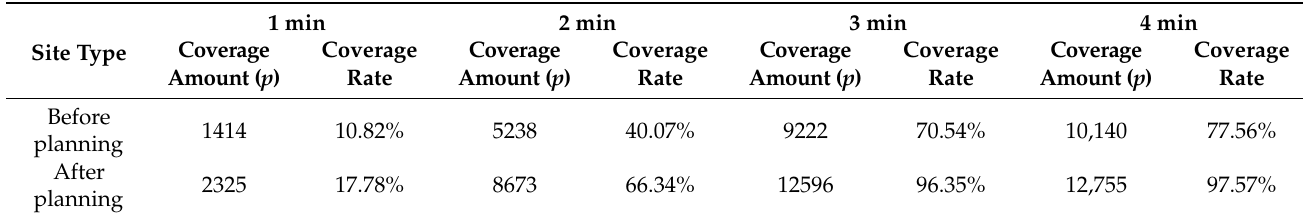
Table 5. Coverage of POIs in different time periods before and after planning.